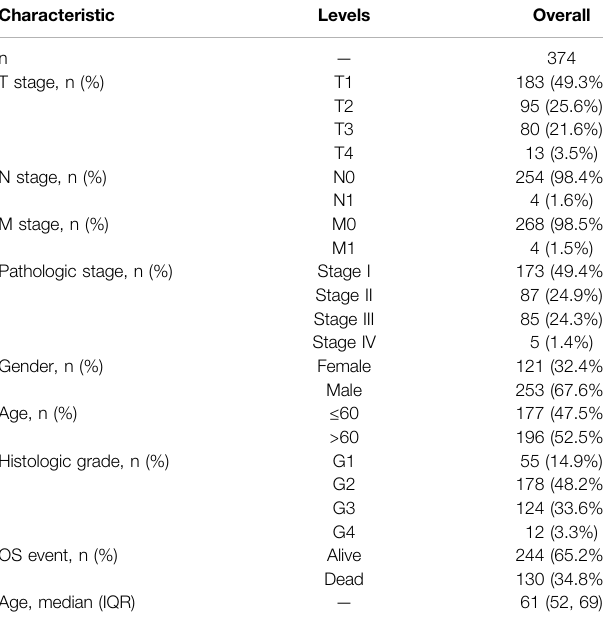
TABLE 2 | Clinical characteristics of the HCC patients used in the validation cohort. Characteristic